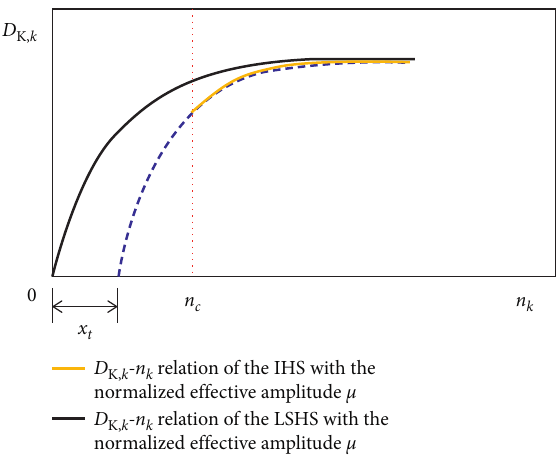
Figure 11: The translation model of LSHS.